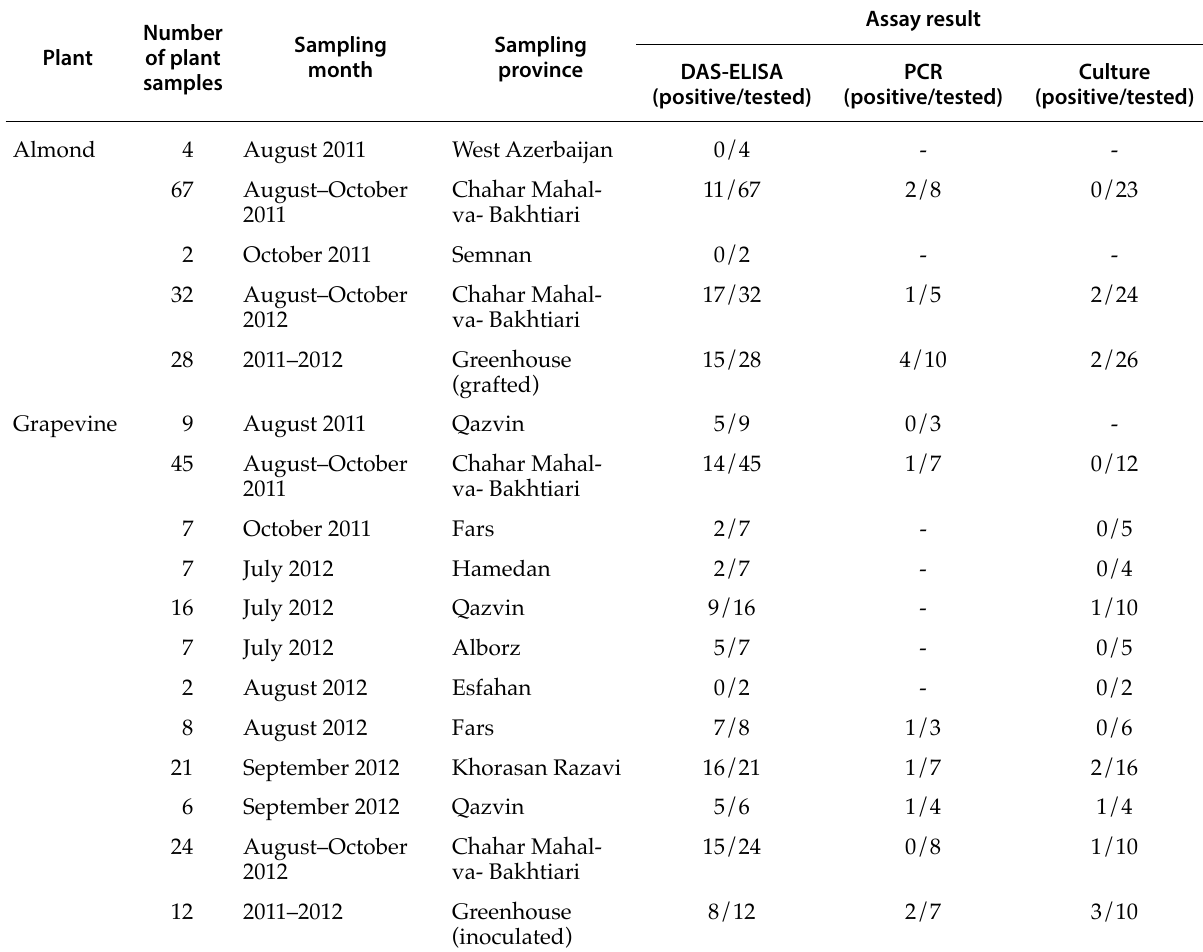
Table 1. Comparison of Xylella fastidiosa detection methods in symptomatic almond and grapevine plant samples from Iran a .